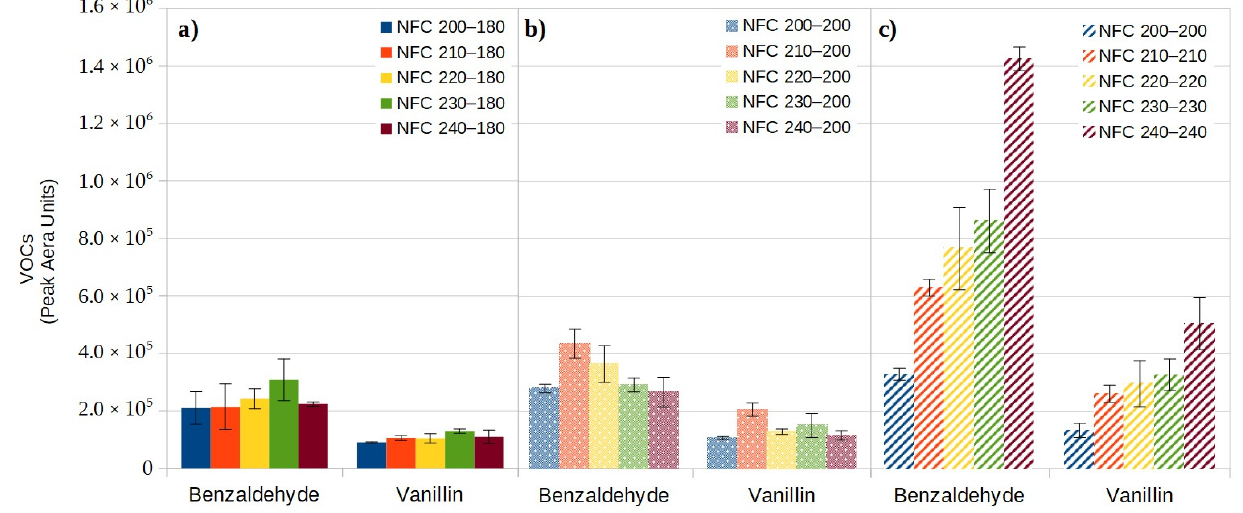
Figure 6. VOCs coming from the degradation of lignin: benzaldehyde and vanillin methylfurfural as a function of molding temperature conditions for a core temperature of ( a ) 180 °C, ( b ) 200 °C and ( c ) going from 200 °C to 240 °C.